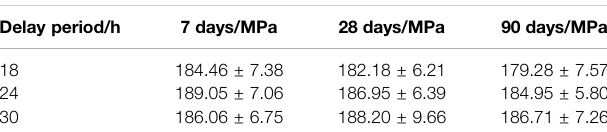
TABLE 4 | Compressive strength of RPC.